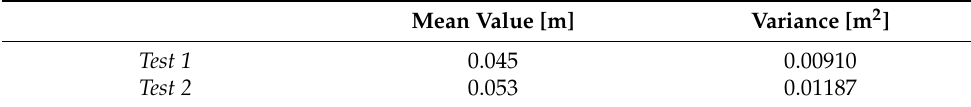
Table 2. Mean value and variance of the position estimation error in Test 1 and Test 2